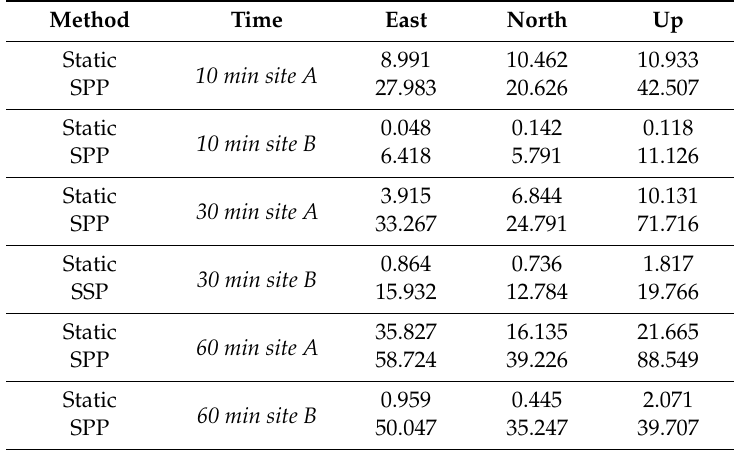
Table 4. Huawei P10 + . Results obtained with RTKLIB software, considering di ff erent session lengths and locations. Values in meters.